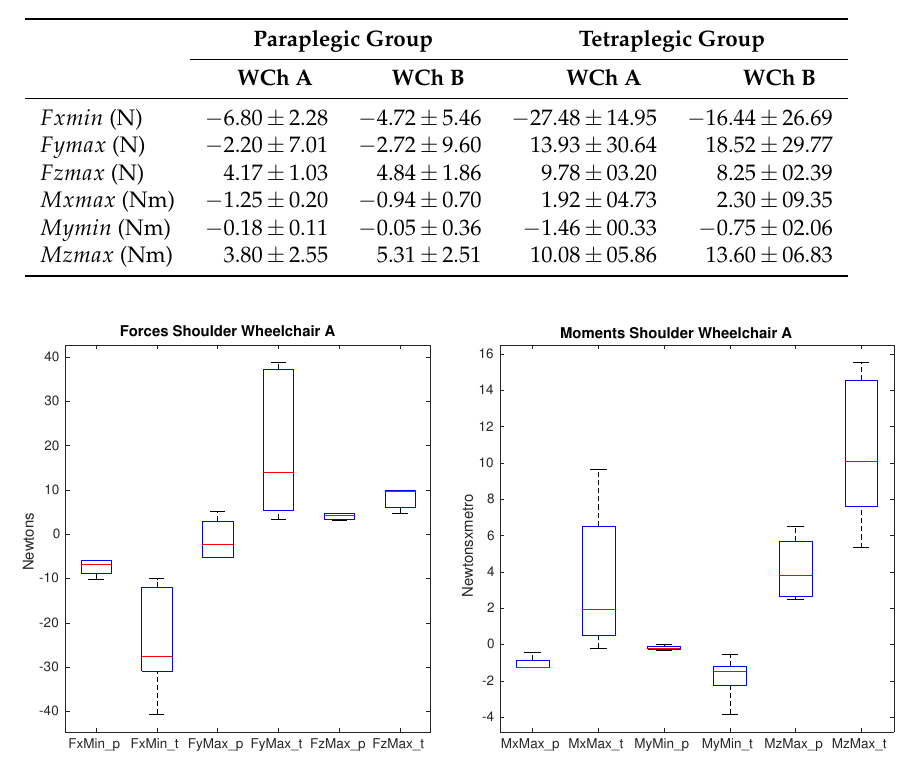
Figure 5. Forces and moments that show significance on the shoulder between paraplegics and tetraplegics when propelling wheelchair A. FxMin represents the minimum value of posterior force on the shoulder, FyMax shows the maximum lateral force on the shoulder, FzMax represents the maximum superior force. MxMax shows the maximum value of the adduction moment, MyMin the minimum value of the extension moment and MzMax the maximum value of the internal rotation moment on the shoulder. In all cases, the values for paraplegics (_p) and tetraplegics (_t) are